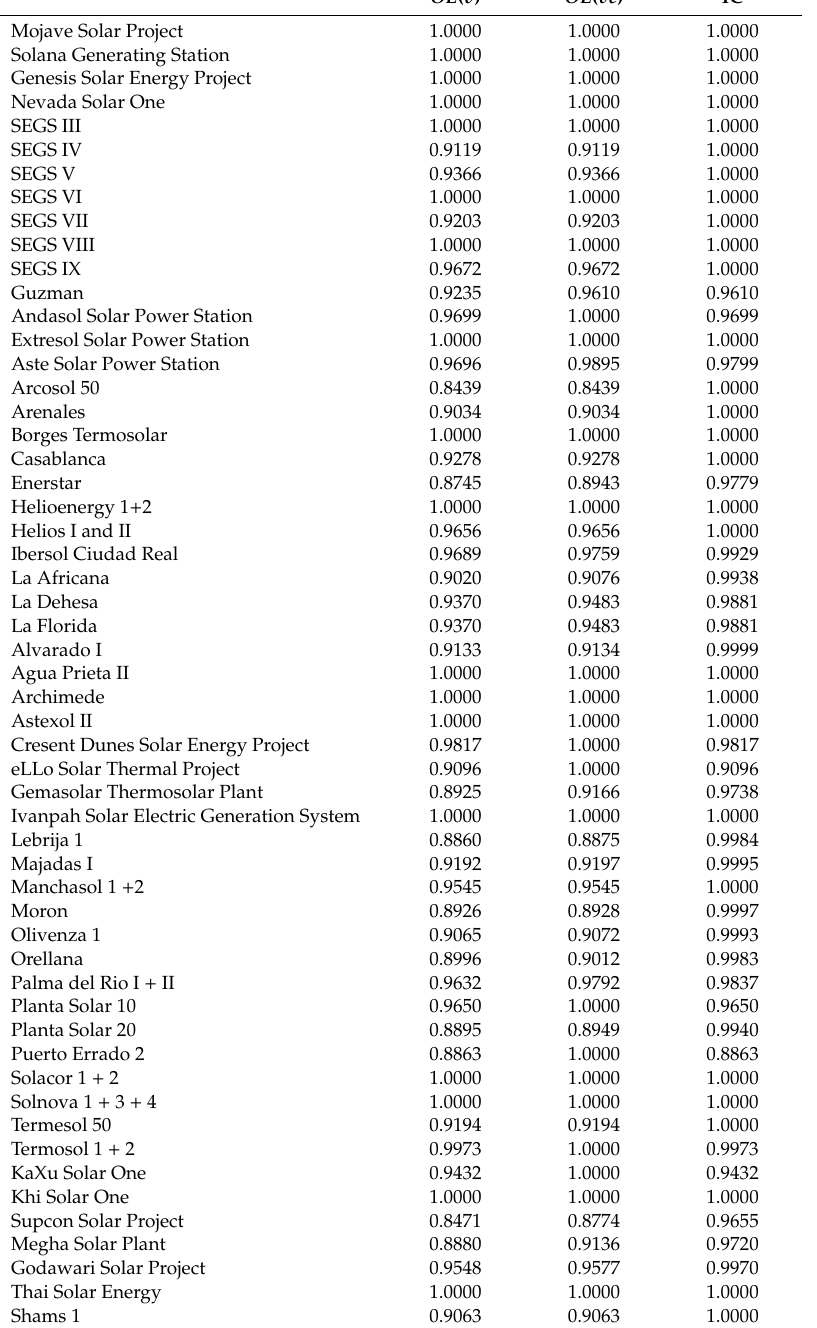
Table 5. Operational e ffi ciency and input-based